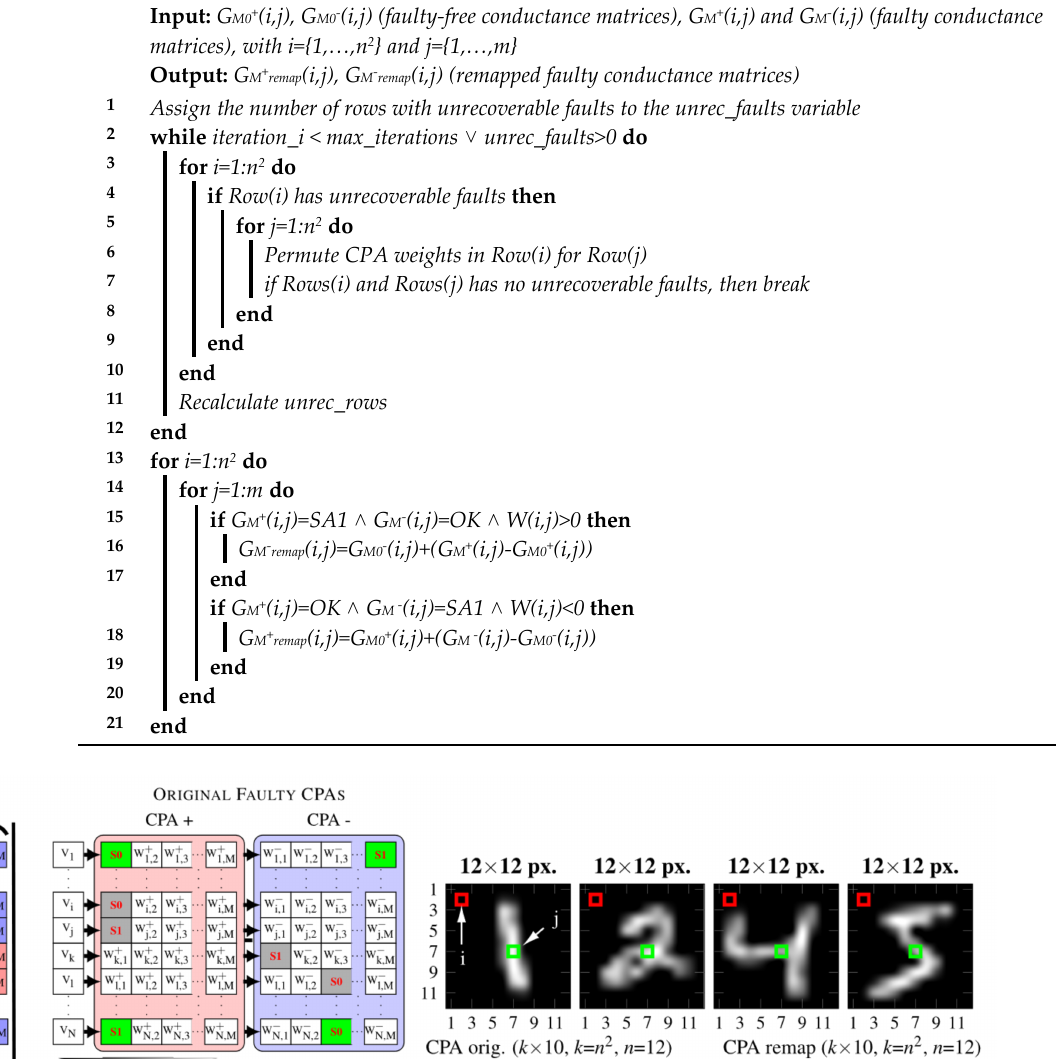
Algorithm 1: Fault-tolerant adaptive mapping